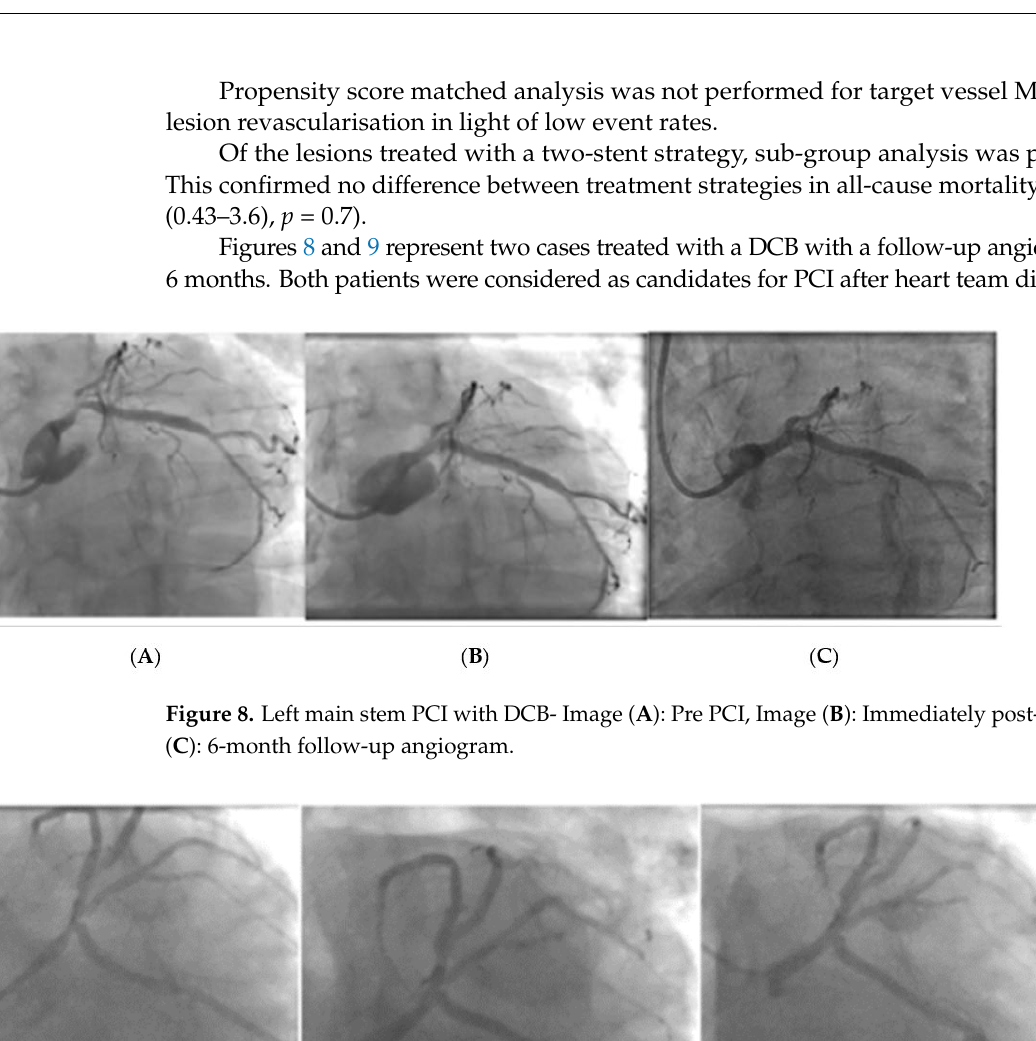
Figure 7. Kaplan–Meier estimator analysis of repeat revascularisation for paclitaxel DCBs vs. sec- ond-generation DESs for de novo LMS disease. It shows no significant difference between the groups.